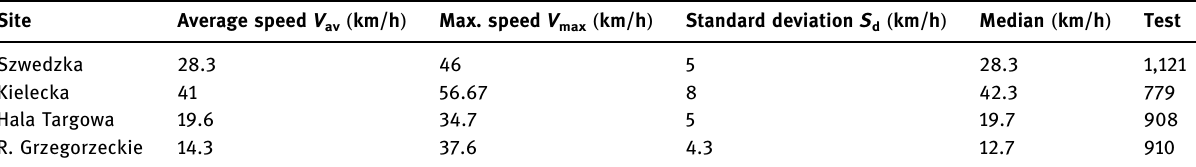
Table 3: Tram speed at di ff erent locations ( bold without fatal accident )